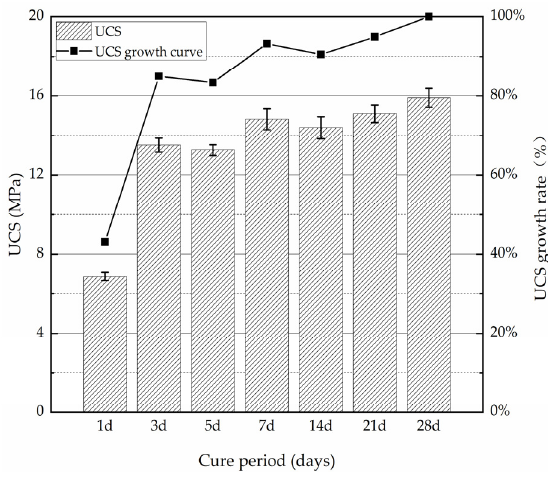
Figure 10. UCS development of PMMRS during the curing period.